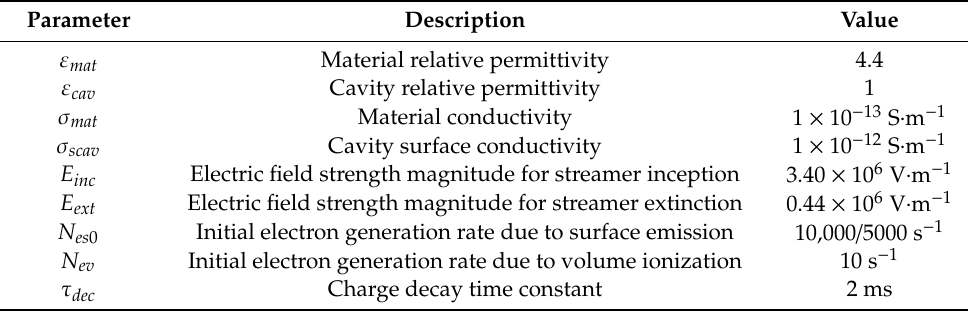
Table 7. Parameters definition for the simulation of the case study.